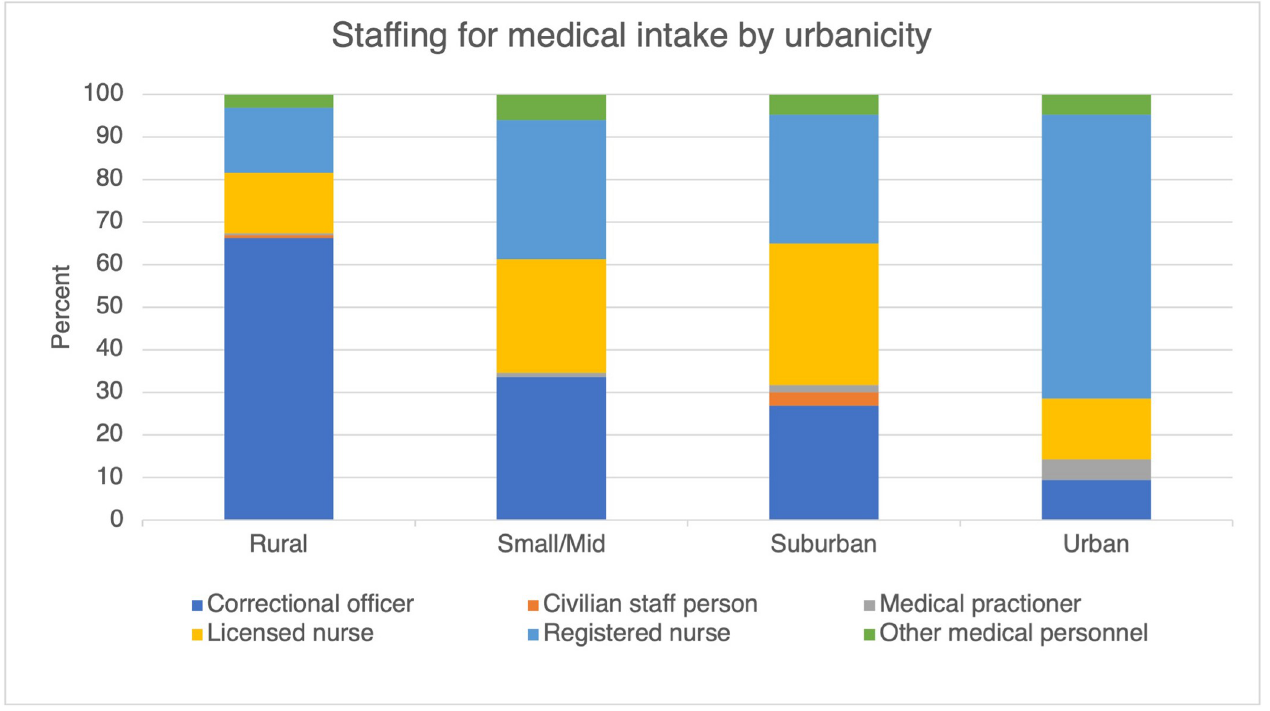
Fig 4. Staffing for medical intake by